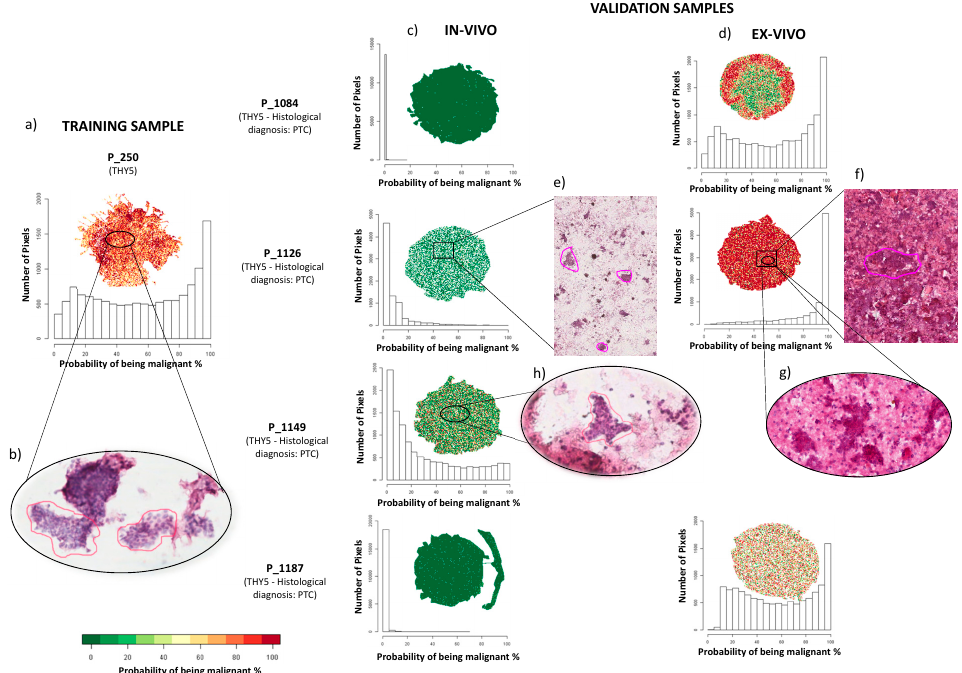
Figure 2. Examples of pixel-by-pixel images and distributions of the probabilities of being malign in the training and validation set of malignant Thy5 nodules. ( a ) imzML MALDI-MSI data of the Thy5 P_250 in the training sample; ( b ) H&E staining image of P_250; validation of ( c ) in vivo Thy5 samples and ( d ) ex vivo Thy5 samples using imzML MALDI-MSI data; ( e ) low cellularity in the H&E staining image of the P_1126 in vivo sample; ( f ) high cellularity in the H&E staining image of P_1126 ex vivo sample and ( g ) a zoom-in of thyrocyte clusters; ( h ) H&E staining image of high-quality cluster of thyrocytes cells of P_1149 in